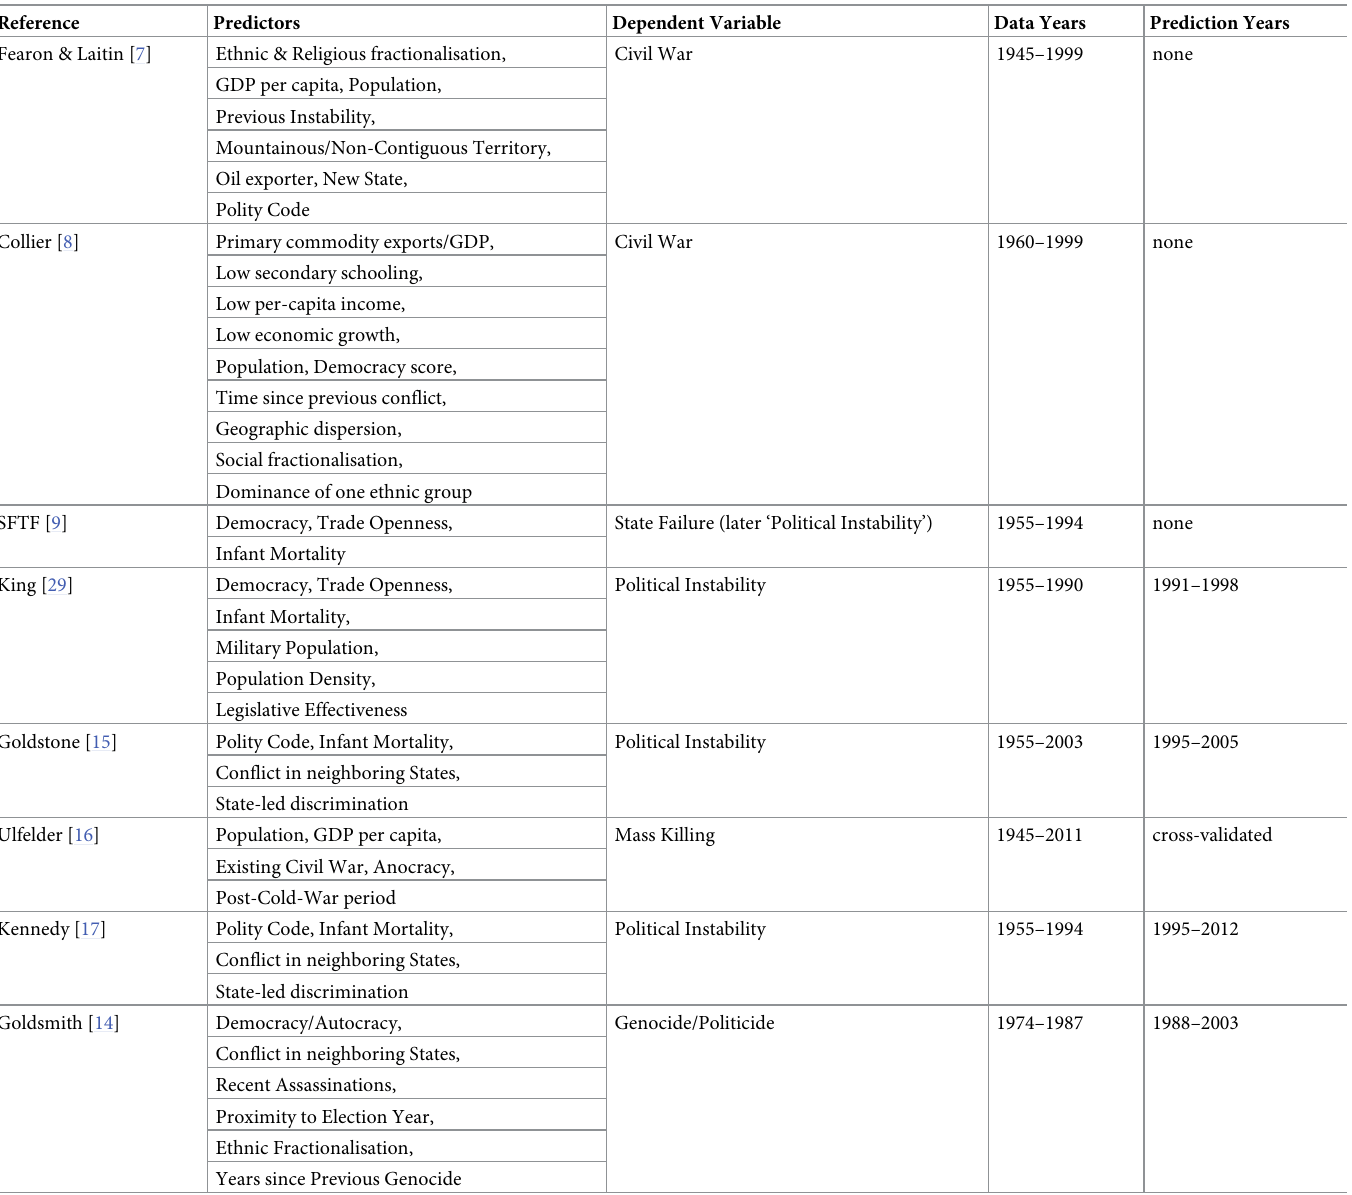
Table 1. Models of